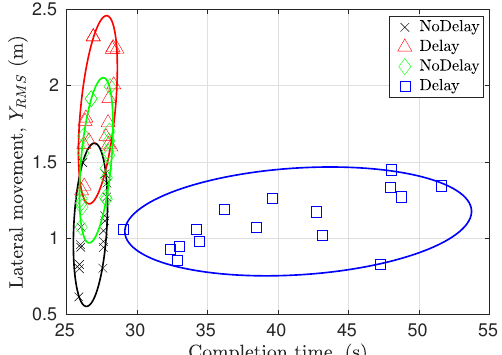
Figure 20. Scenario 2—Performance assessment summary. At the cost of higher completion time, SRPT mode resulted similar lateral movement as observed in No-delay mode. Lesser lateral move- ment indicates better